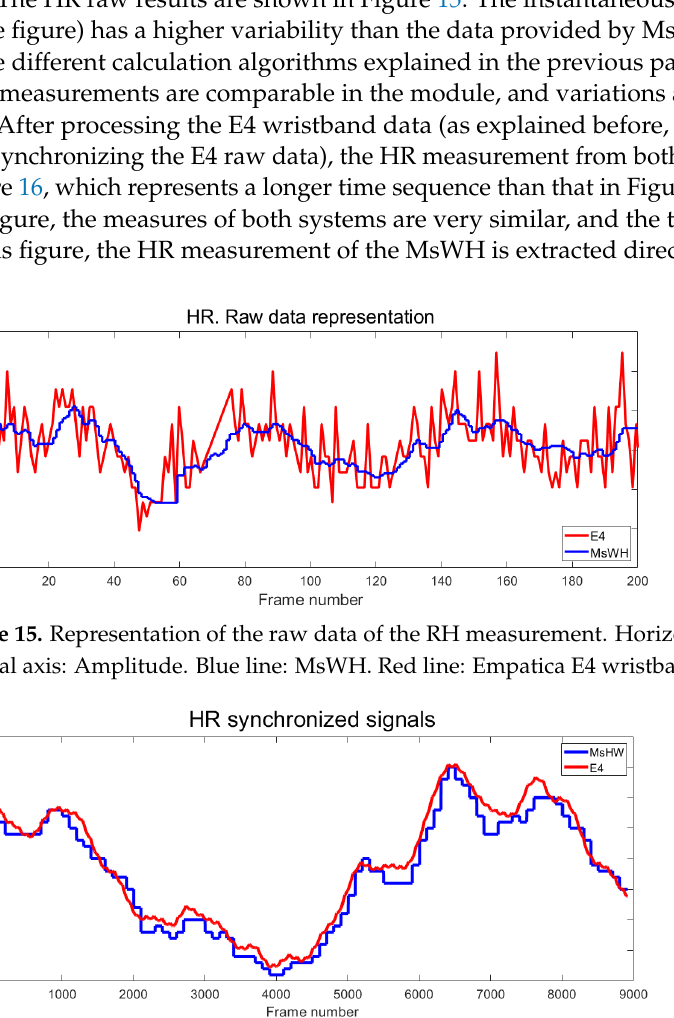
Figure 16. HR synchronized signals. Horizontal axis: frame number. Vertical axis: Amplitude. Blue line: MsWH. Red line: Empatica E4